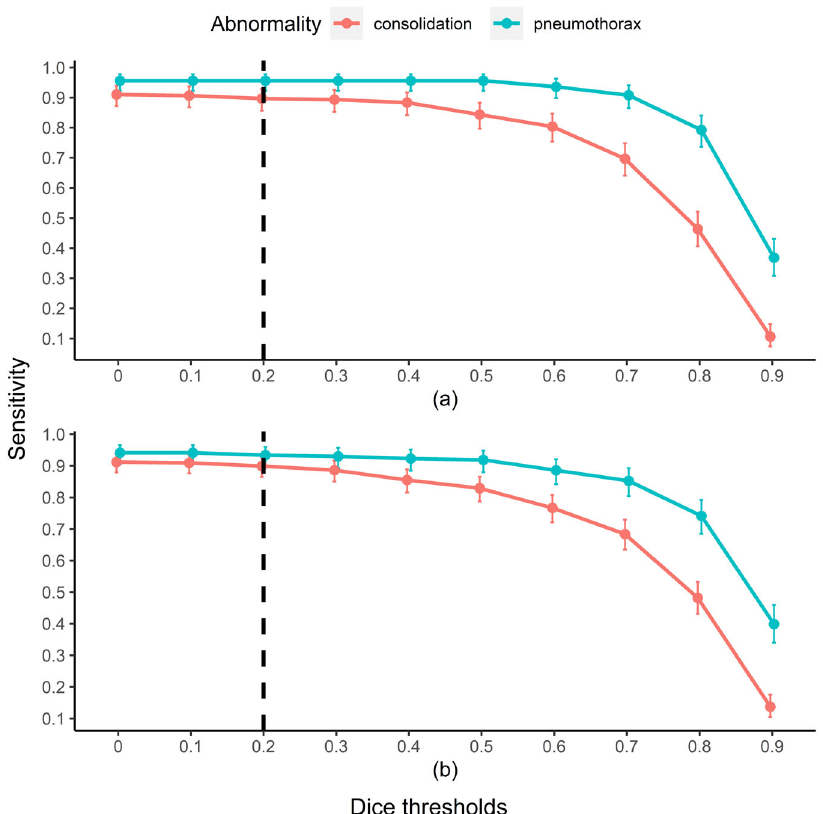
Fig. 1 CAD sensitivities by varying dice thresholds in the stand-alone trial. Sensitivities are presented at a the image-level and at b the lesion-level. The 95% con fi dence intervals are drawn as error bars at each point. The black dashed line indicates the minimum threshold of clinical relevance (i.e., dice = 0.2). Raw values are presented in Supplementary Table 1. CAD Computer-aided detection